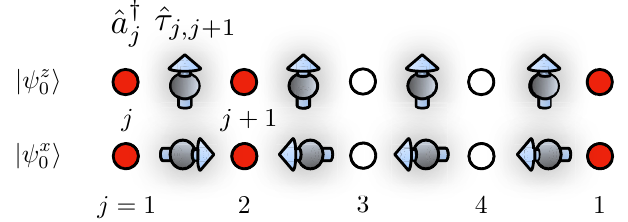
FIG. 2. The two initial states considered in this work. Both are domain walls on a periodic chain from the perspective of hard-core bosons, with matter sites on the left half of the chain singly occupied (red filled circles), while those on the right half are empty (open circles). The main difference lies in the orien- tation of the electric field on the links between matter sites. In (cid:3) , the electric fields are oriented along the positive the case of | ψ x 0 ˆ (cid:3) = | ψ x (cid:3) for all j , making or negative x direction such that G j | ψ x 0 0 this initial state gauge invariant. In contrast, the electric fields are (cid:3) , render- aligned along the positive z direction in the case of | ψ z 0 ing the latter a translation-invariant gauge-noninvariant super- position of gauge-invariant superselection sectors (see Table